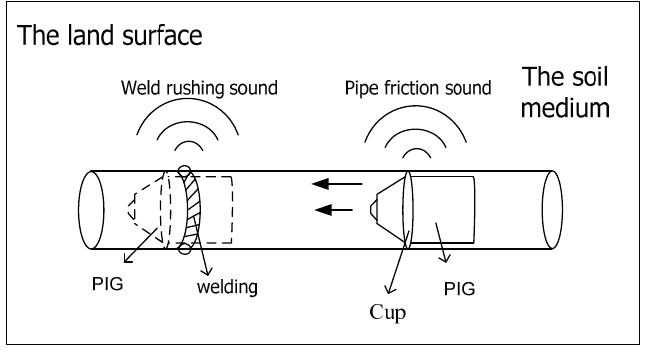
Figure 1. Sound generating principle of a PIG in a pipe.